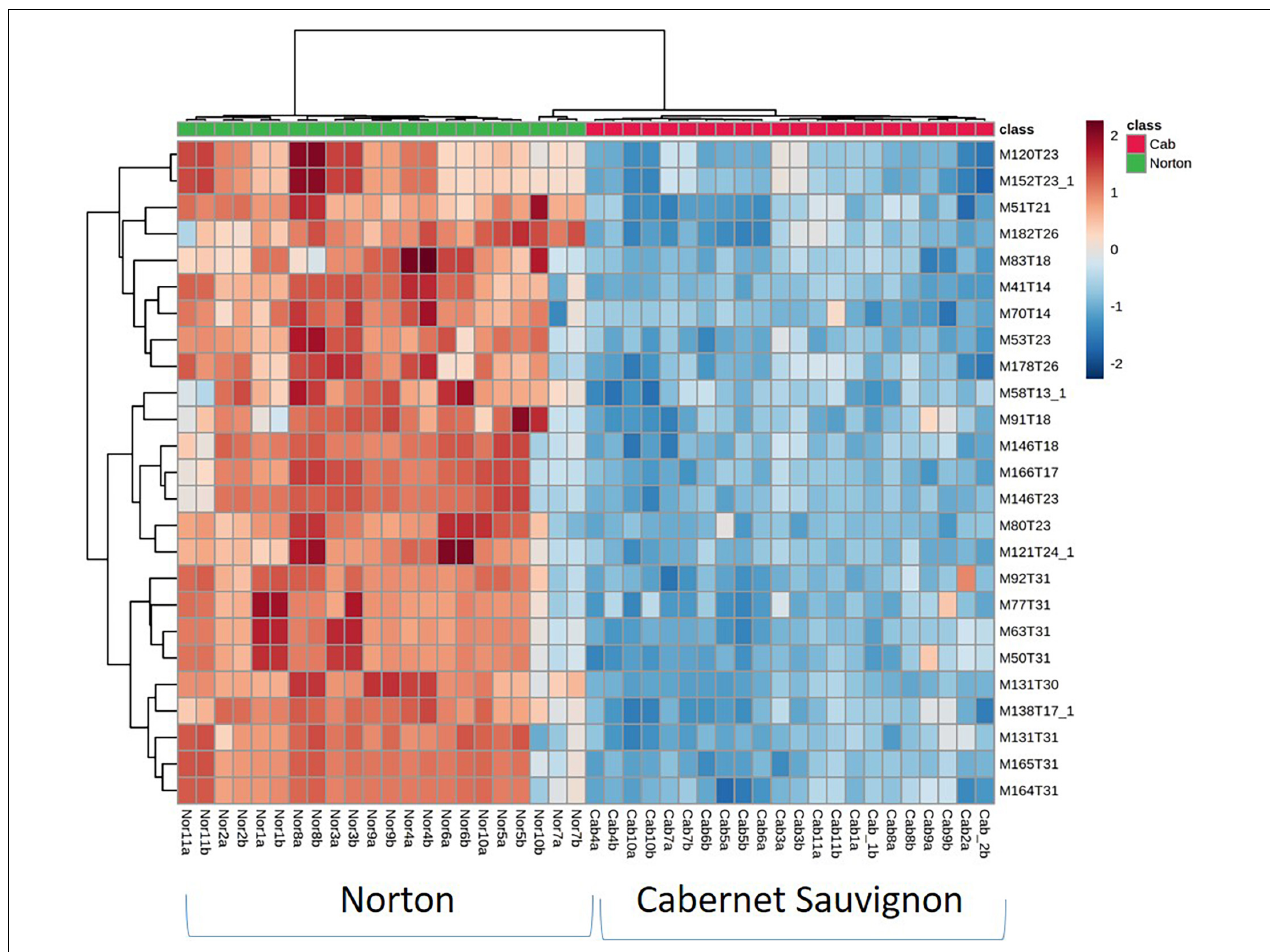
FIGURE 2 | Heatmap of the top 25 most influential features for differentiating wine volatiles between Norton and Cabernet Sauvignon. While only top contributors are shown the heatmaps were generated using all the features. The rows in the heatmap represent features [M (m/z),T (time in minutes)] and the columns indicate sample categories. The colors of the heatmap cells indicate the abundance of compounds across different samples. The color gradient, ranging from dark blue through white to dark red, represents low, middle, and high abundance of a compound,